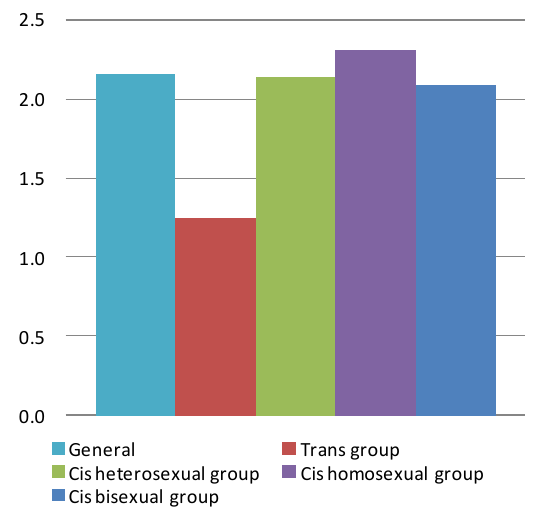
Fig. 5 – Average of grades by each